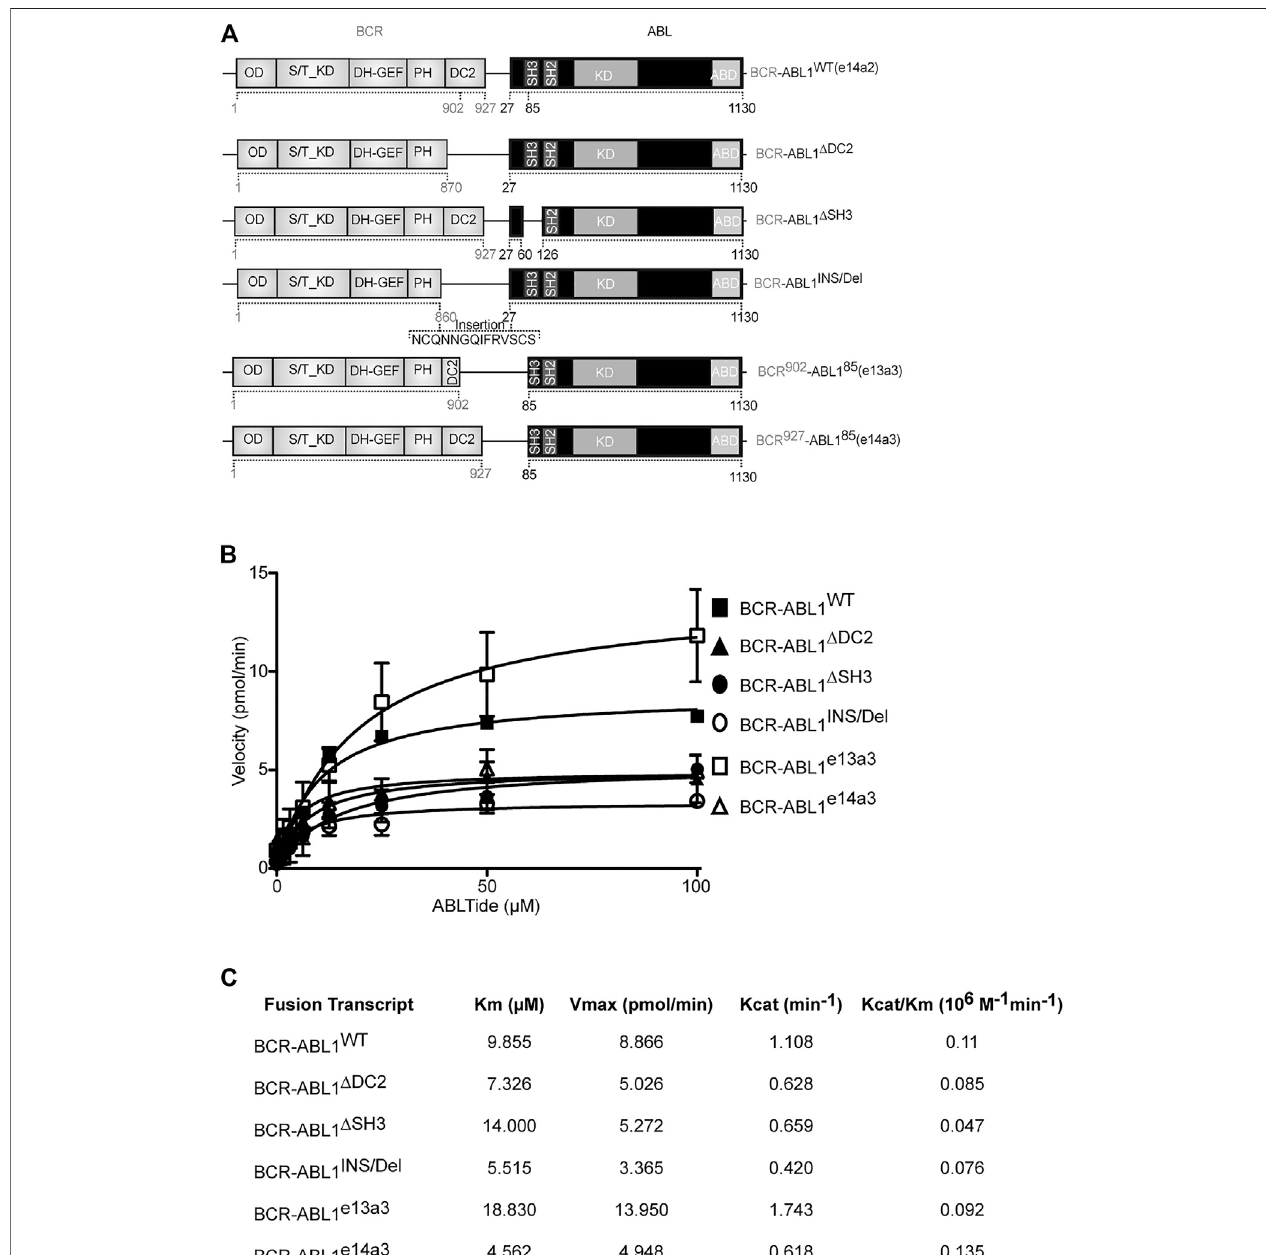
FIGURE 1 | BCR-ABL1 catalytic ef fi ciency is modulated by its breakpoint region. (A) Schematic representation of the BCR-ABL1 constructs used in this study. Numbers indicate the amino acid positions involved in the deleted region. (B) Curves show the results of an in vitro kinase assay plotting velocity versus substrate concentration using the indicated 6xHIS constructs. Assays were performed in triplicates with the standard deviation of the velocities shown as error bars. (C) Panel reportingthe enzymatic values ofsubstrate-binding ratesexpressed astheMichaelis-Menten constant( Km ),maximum reaction rate( Vmax ),the catalytic constant rate ( Kcat )and the Kcat / Km ratio de fi ning catalytic ef fi ciency.OD: OligomerizationDomain; S/T_KD: Serine Threonine Kinase Domain; DH-GEF (DblHomologyDomain- GuanineNucleotide Exchange Factor); PH(Pleckstrin HomologyDomain);DC2: C2domain; SH3-SH2: Srchomology domains;KD:kinase domain, ABD: ActinBinding